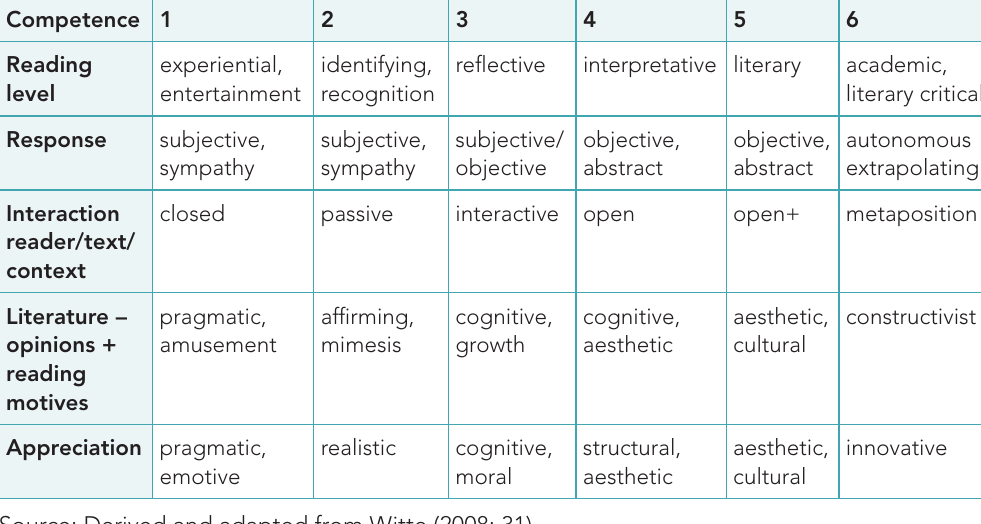
Table 1: Development model of literary